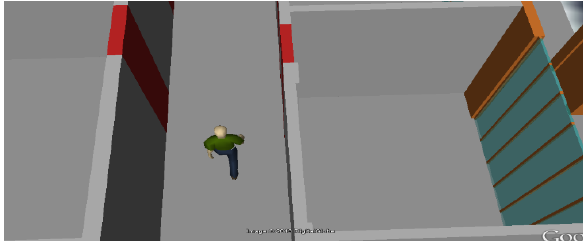
Figure 7. 3D virtual world system interface.